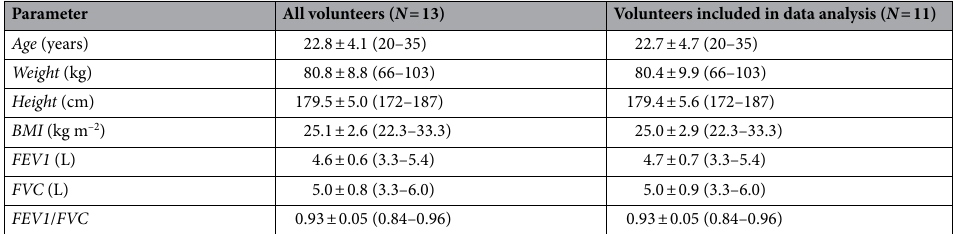
Table 2. The basic characteristics of the group of volunteers involved in the breathing experiment. The values are presented as mean ± standard deviation and range (minimum–maximum). BMI body mass index, FEV1 forced expiratory volume in 1 s, FVC forced vital